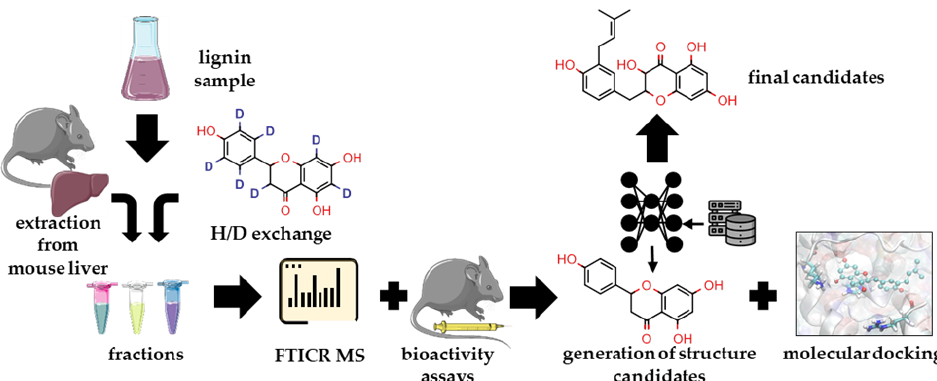
Figure 1. The dereplication pipeline used in this work. H/D exchange was used to label lignin-derivative and find its component in liver by FTICR MS. The sample and its enriched fraction were tested on its ability to alleviate NADFL-related biochemical changes. LC-MS experiments assessing the ability of samples to interact with the KEAP-1 were then performed. Further, a recurrent neural network was trained on the natural compound structures from CoCoNut and fine-tuned on compounds possessing activity against KEAP1-Nrf2 system retrieved from ChEMBL. The network was used to sample various natural compound-like structures that were filtered by the relevance according to the experimental MS data including isotopic labeling. Finally, the ability of the filtered compounds to interact with the KEAP-1 was assessed using molecular docking simulations.